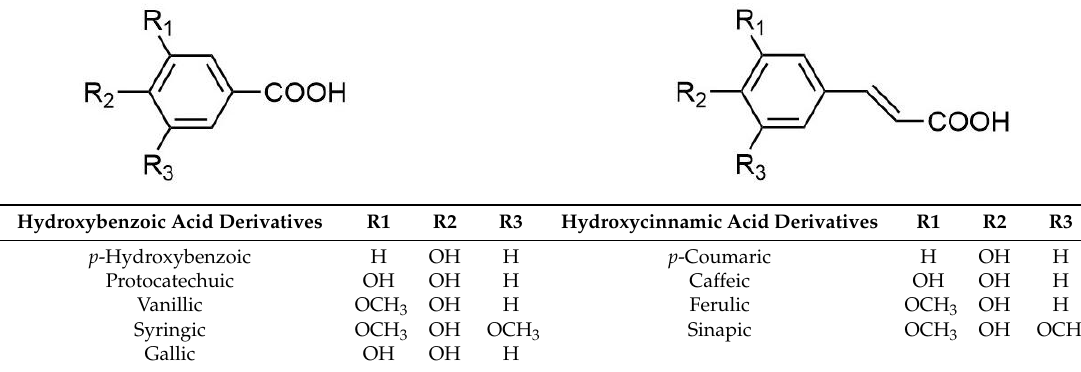
Figure 1. Chemical groups of each acid